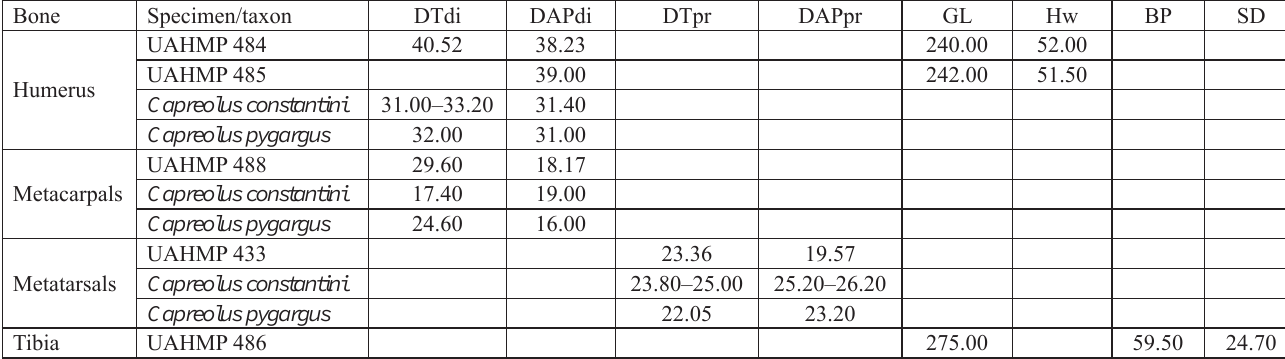
Table 2. Postcranial measurements (in mm) of Capreolus constantini from Hidalgo, Mexico (UAHMP specimens) and C. constantini and C. pygargus from Udunga, Russia (after Vislobokova et al. 1995). DTdi, distal transverse diameter; DAPdi, distal anteroposterior diameter; DTpr, proximal transverse diameter; DAPpr, proximal anteroposterior diameter; GL, greatest length; Hw, head width; BP, greatest width of the proximal end; SD, smallest